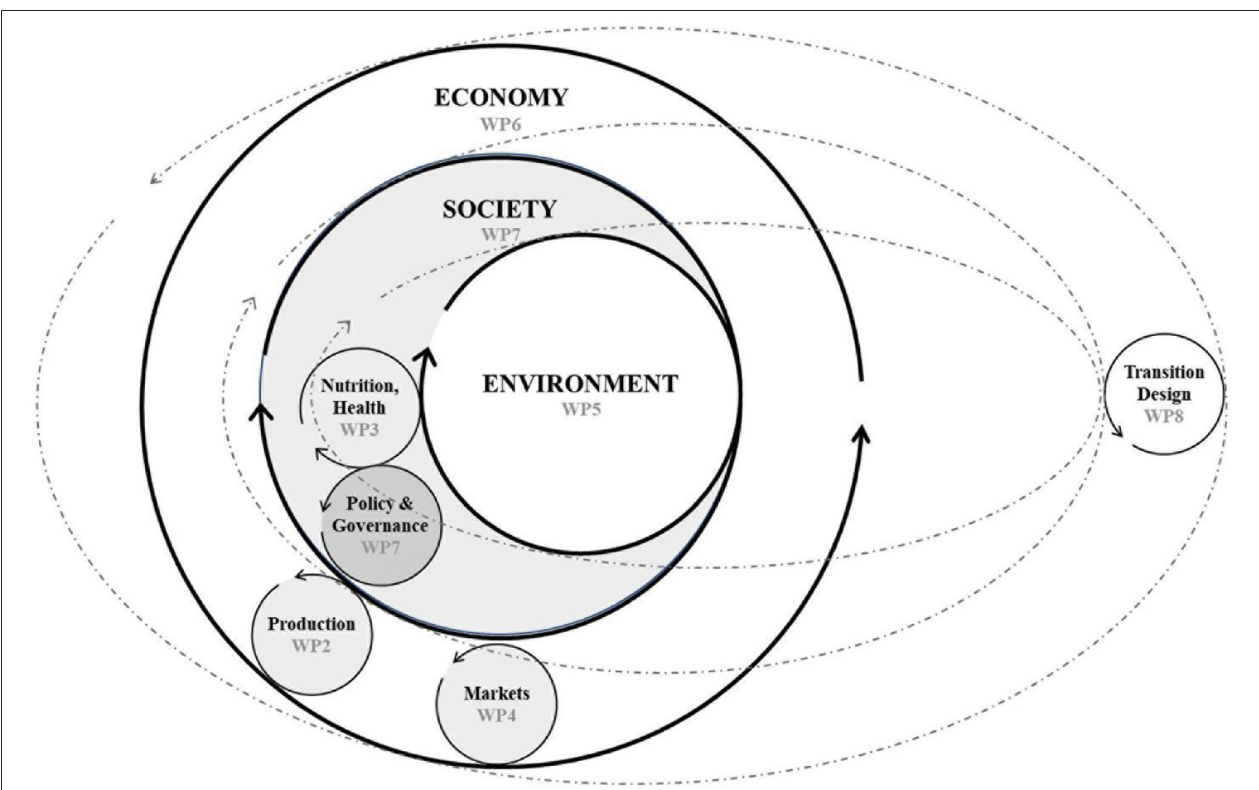
FIGURE 1 | The focal structure and ambition of the EU-funded TRUE-Project has adapted a functional perspective of the Three Pillars of Sustainability (economic, environmental, and social) and with respect to the UN Sustainable Development Goals. The TRUE-Project identifies focal indicators for each Pillar which are built into the TRUE “Pathfinder” Decision Support System [work package WP 8], and value chain sustainability assessment tool. This schematic diagram is adapted from Figure 3 of Vasconcelos et al. (2020), to highlight where the TRUE-WPs reside relative to the “Pillar-WPs” (5, 6, and 7). Furthermore, the structure highlights the pivotal role of policy and good-governance to ensure safeguarding environmental function and nutritional qualities which also ensure good-health and well-being—since these core elements should be harmonized with a more-facilitative economic